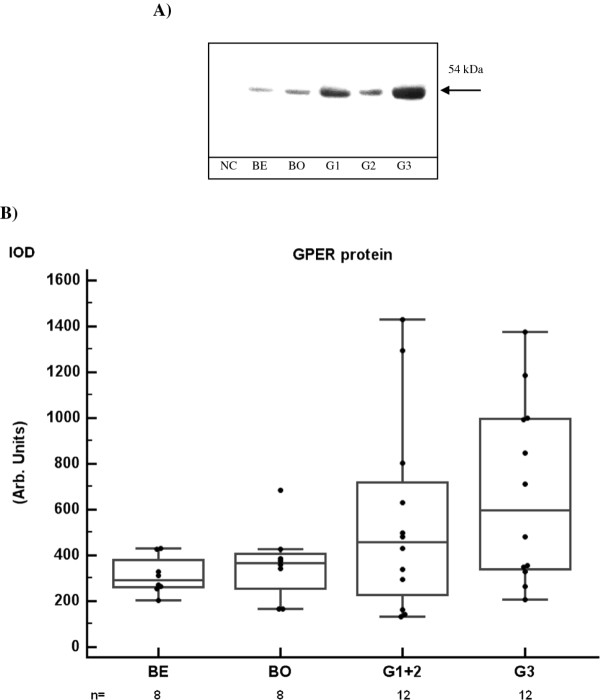
Western blot of GPER in ovarian tumors with semi-quantification A) GPER protein was detected as a single band at 54 kDa in Western blots of primary ovarian tumor extracts. Abbreviations are as in Figure 1. NC = negative control (extract from HEK-293 cells). B) The tissue content of GPER protein was semi-quantified by densitometric scanning of the bands, and presented as integrated optical density (IOD). The number of samples (n) in each group is given in the graph. GPER protein levels were not different between benign/borderline tumors and malignant tumors, although G3 tumors had higher level than benign tumors (p = 0.03). However, the number of samples with elevated GPER protein (> 500 arbitrary cut-off) was higher in malignant (10/24) than in benign/borderline tumors (1/16), (p = 0.01, Fisher's exact test).